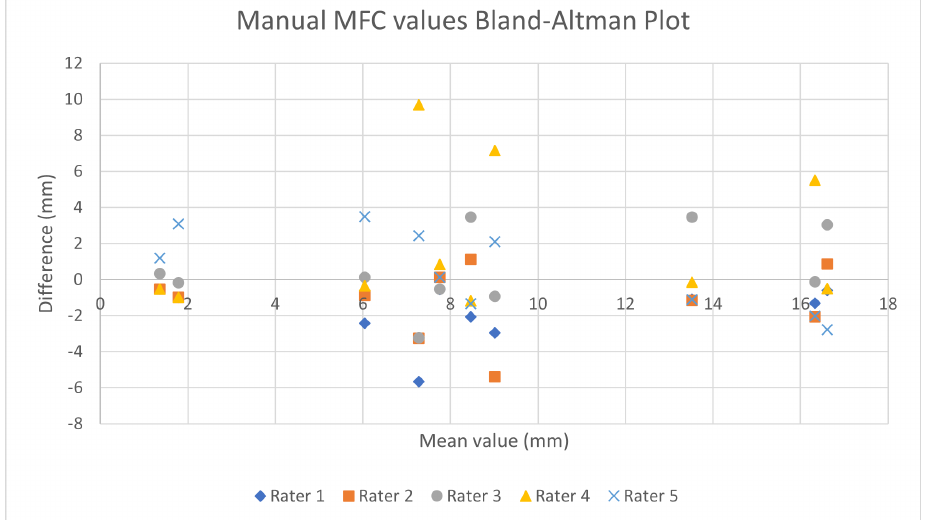
Figure 8. The Bland-Altman plot showing the inter-rater agreement between the five raters in the final evaluation.